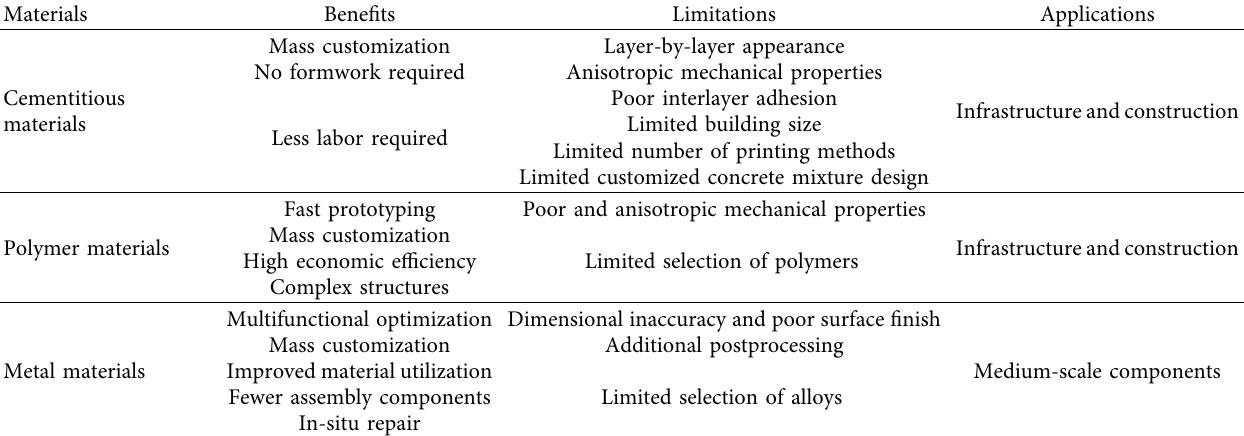
Table 3: Current state of the art of materials.